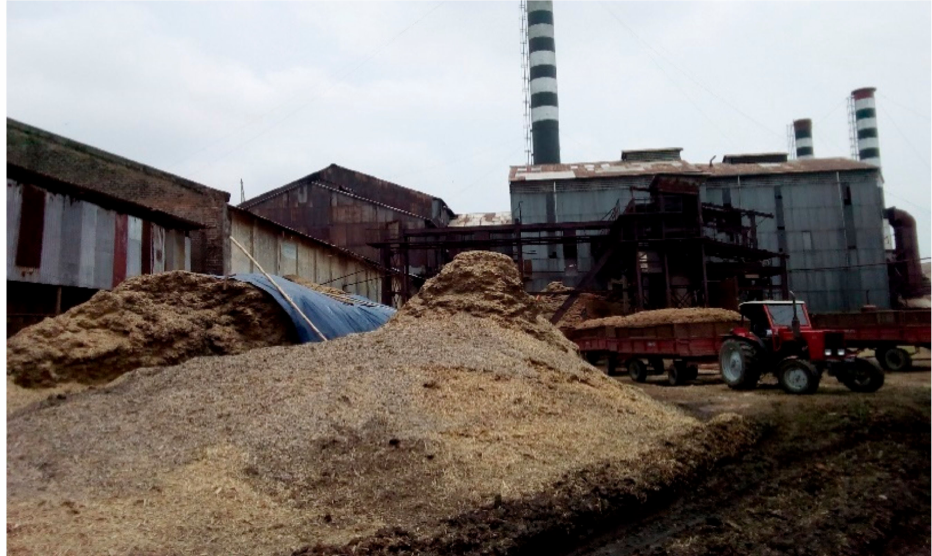
Figure 3. Disposal site of bagasse ash (BA).